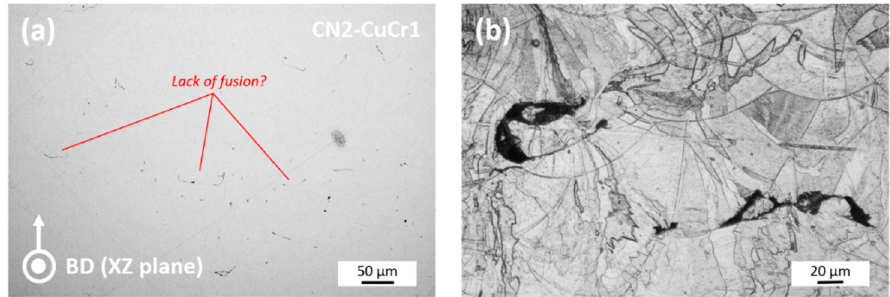
Figure 4. ( a ) Build direction (XZ plane) cross-sectional surfaces for the CN2-CuCr1 specimen; ( b ) zoomed-in etched section to highlight the observed lack-of-fusion porosities.